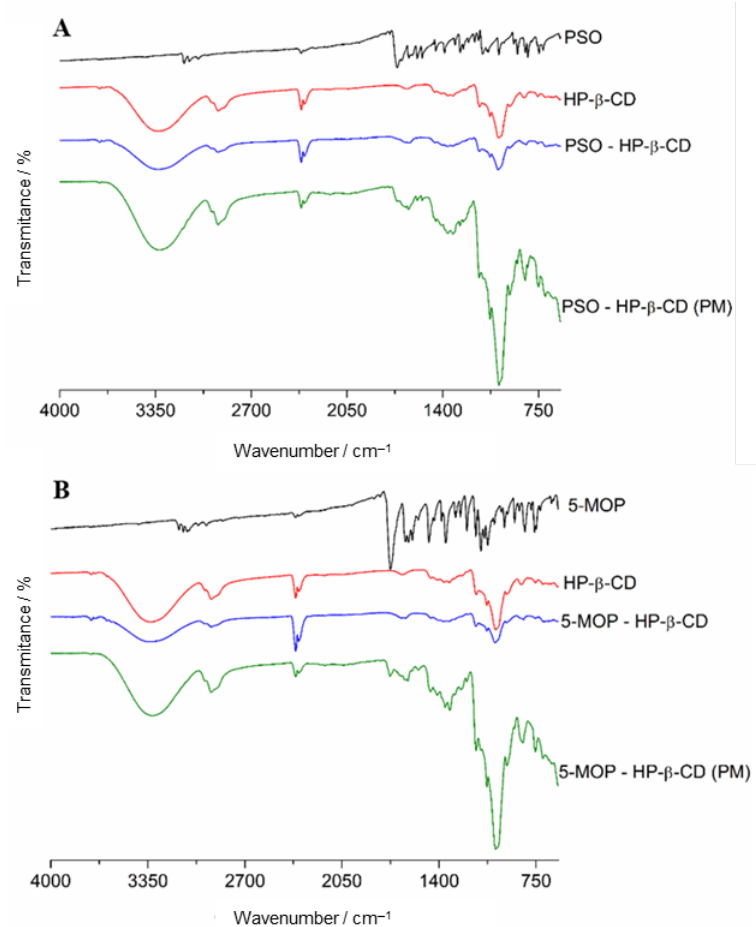
Figure 7. ( A ) ATR-FTIR spectra of PSO, HP- β -CD, physical mixture (PM), and PSO-HP- β -CD inclusion complex (1:1). ( B ) ATR-FTIR spectra of 5-MOP, HP- β -CD, physical mixture (PM), and 5-MOP-HP- β -CD inclusion complex (1:1).